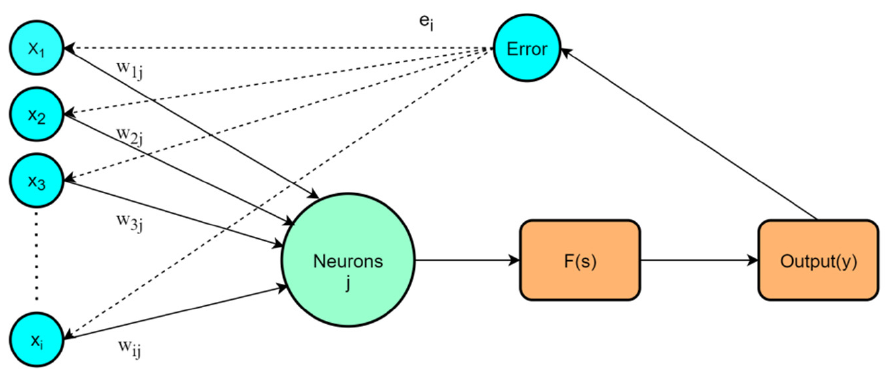
Figure 3. Backpropagation neural network structure.